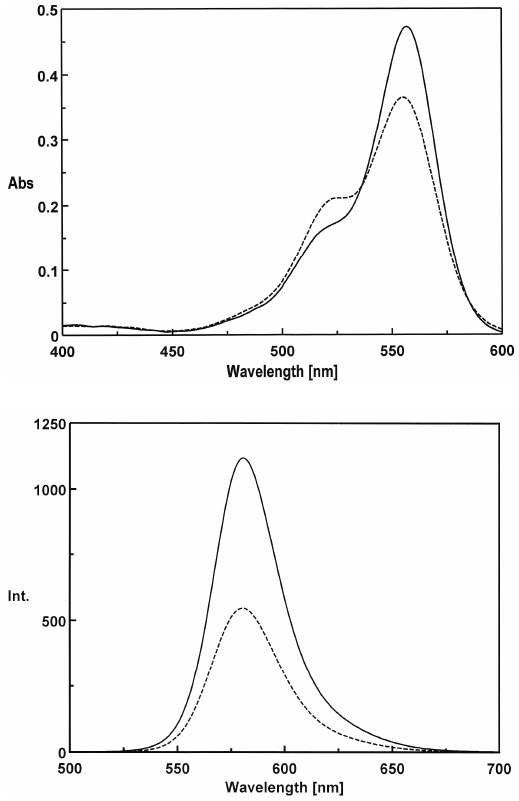
Figure A1. Visible absorption spectra and fluorescence emission spectra for TAMRA-Phos-tag/Pyrophosphate system. ( Top ) Visible absorption spectra at pH 7.4 (10 mM Hepes-NaOH, 0.10 M NaCl) and 25 °C. Solid curve: 5.0 µM TAMRA-Phos-tag, λ max = 557 nm ( ε = 9.7 × 10 4 M − 1 ·cm − 1 ). Broken curve: 5.0 µM TAMRA-Phos-tag + 10 µM pyrophosphate, λ max = 557 nm ( ε = 7.6 × 10 4 M − 1 ·cm − 1 ). ( Bottom ) Fluorescence emission spectra ( λ ex = 523 nm) at pH 7.4 (10 mM Hepes-NaOH, 0.10 M NaCl) and 25 °C. Solid curve: 5.0 µM TAMRA-Phos-tag, λ em = 580 nm (relative intensity = 100%). Broken curve: 5.0 µM TAMRA-Phos-tag + 10 µM pyrophosphate, λ em = 580 nm (relative intensity = 49%).